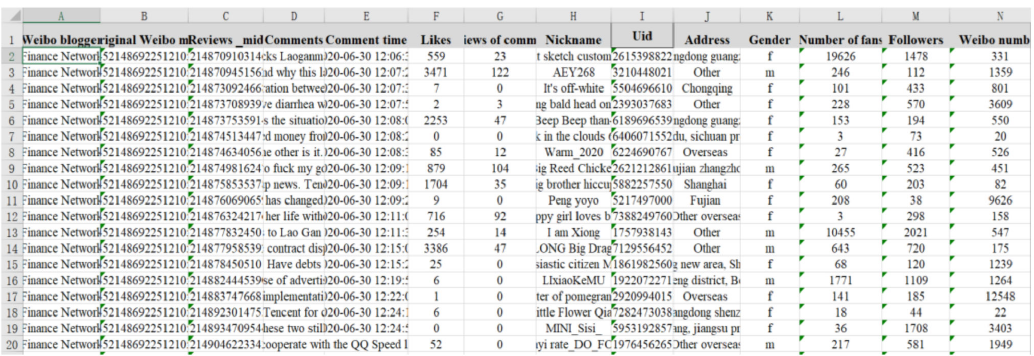
Figure 22. Weibo